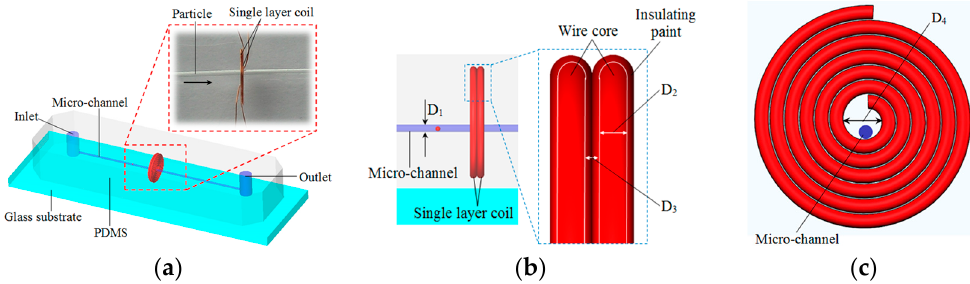
Figure 1. The design of the on-chip impedance sensor: ( a ) The overall design of the chip; ( b ) cross-section of the chip: D 1 is the diameter of the micro-channel, D 2 is the diameter of the coil wire core, D 3 is the distance between the two single-layer coils; ( c ) a sketch of a single-layer coil: D 4 is the inner diameter of the single-layer coil.